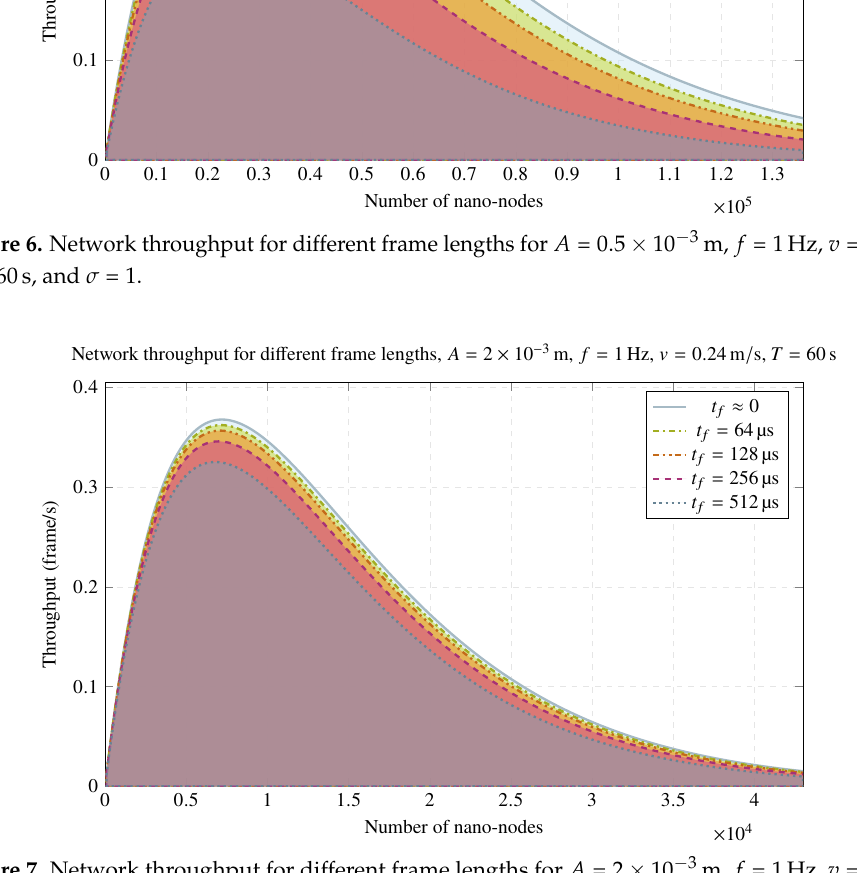
Figure 7. Network throughput for different frame lengths for A = 2 × 10 − 3 m, f = 1Hz, v = 0.24m / s, T = 60s, and σ =